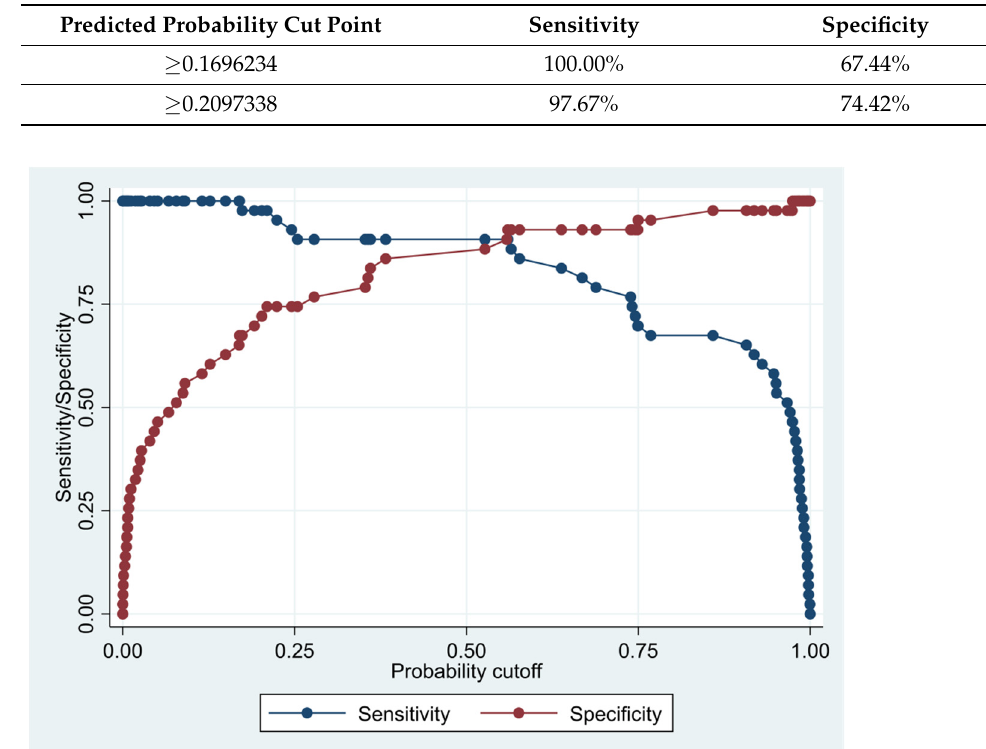
Figure 1. Sensitivity and specificity plot of the final multivariate logistic regression model based on cytokines from the immune-oncology panel.